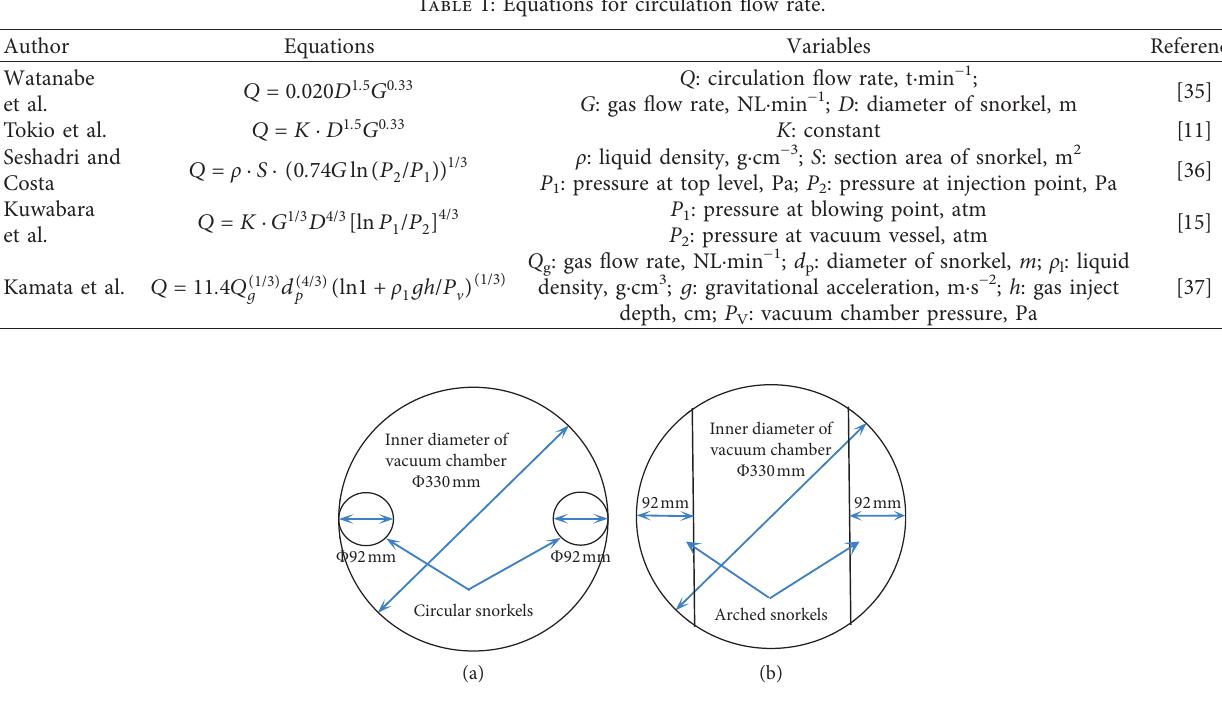
Figure 1: Model schematic of the RH vacuum chamber with (a) circular and (b) arched snorkels (top view). Table 2: Parameters of the prototype and water